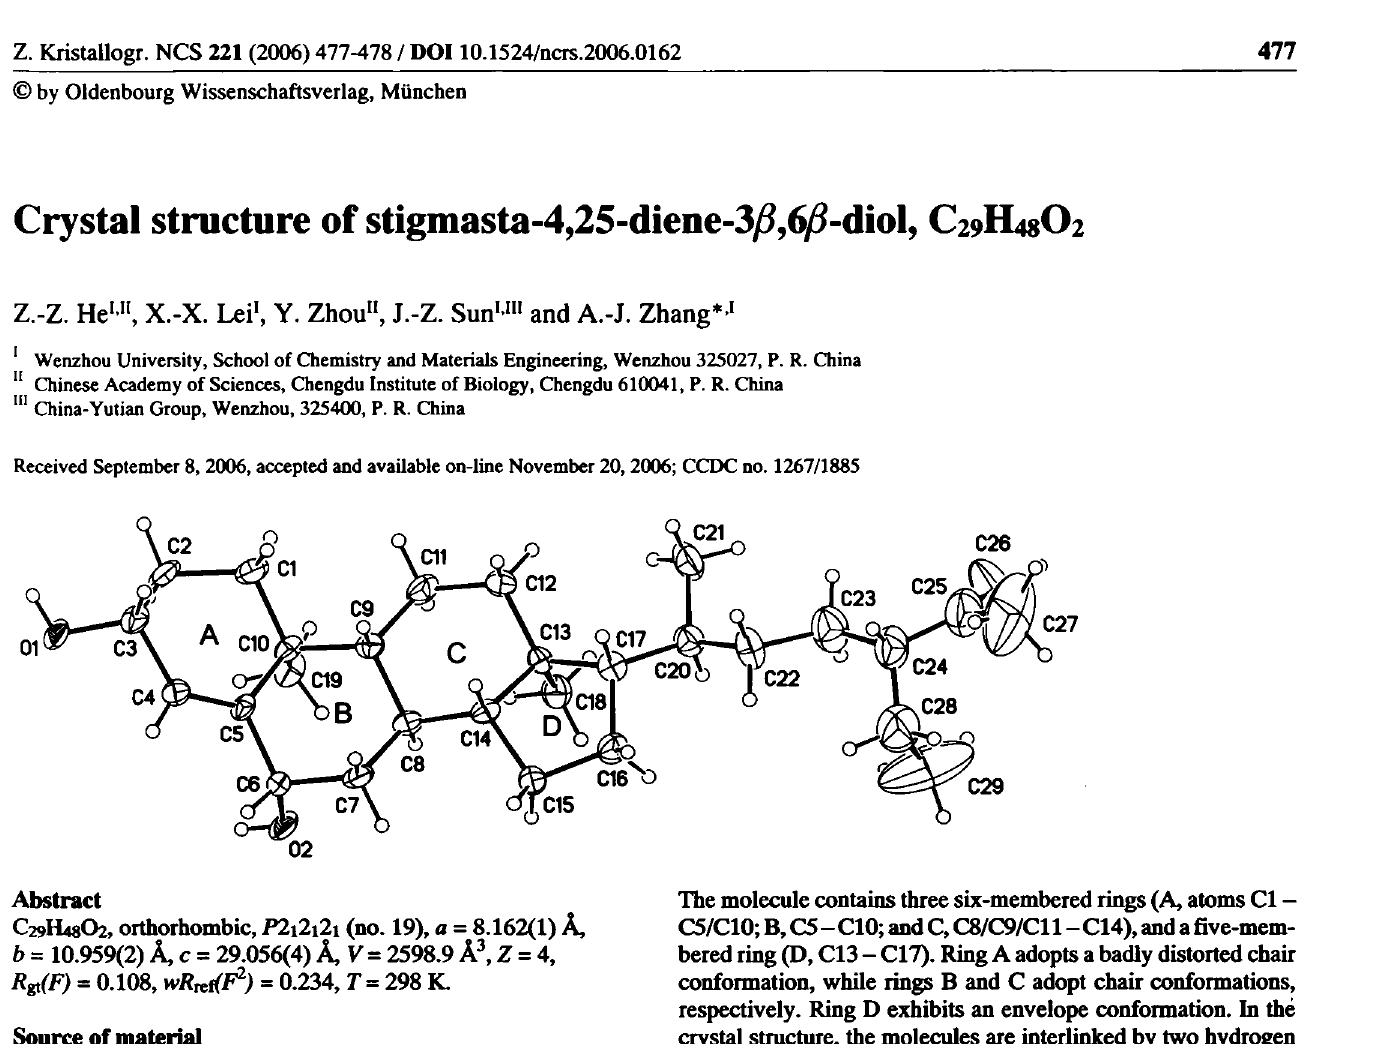
Table 1. Data collection and handling.